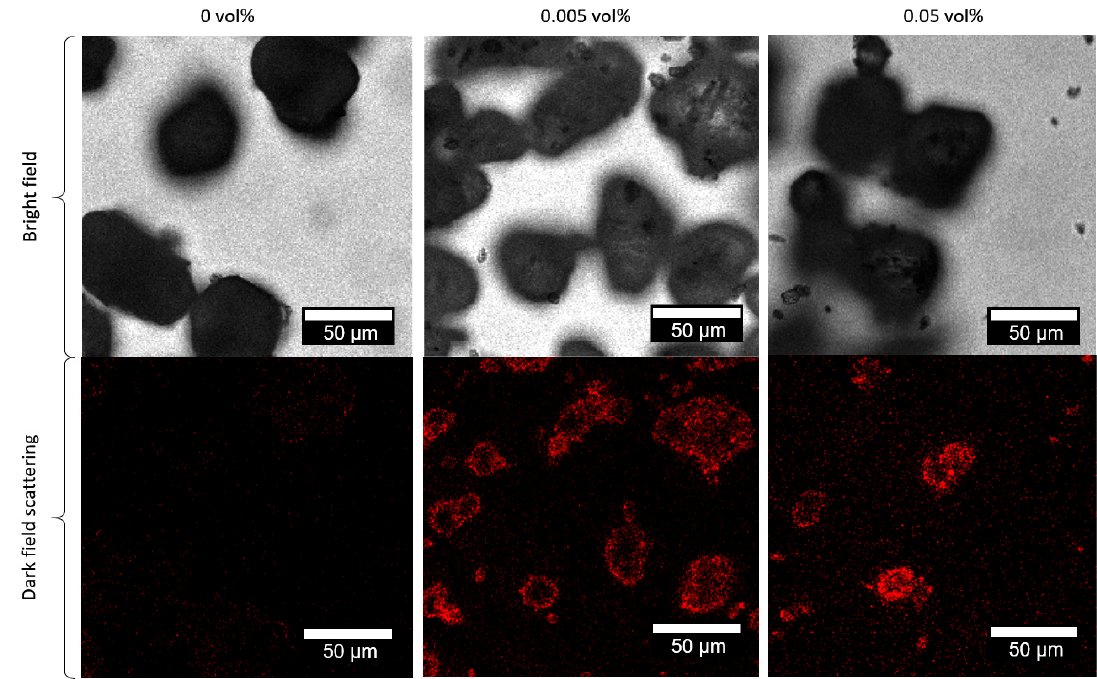
Figure 5. Representative confocal bright field images and laser scanning dark field images of pure PA12 and PA12 colloidal additivated with 0.005 and 0.05 vol% of laser irradiated carbon nanoparticles, respectively. For dark-field imaging, the sample was excited at a wavelength of 500 nm and the detection wavelength was set to 507–587 nm.